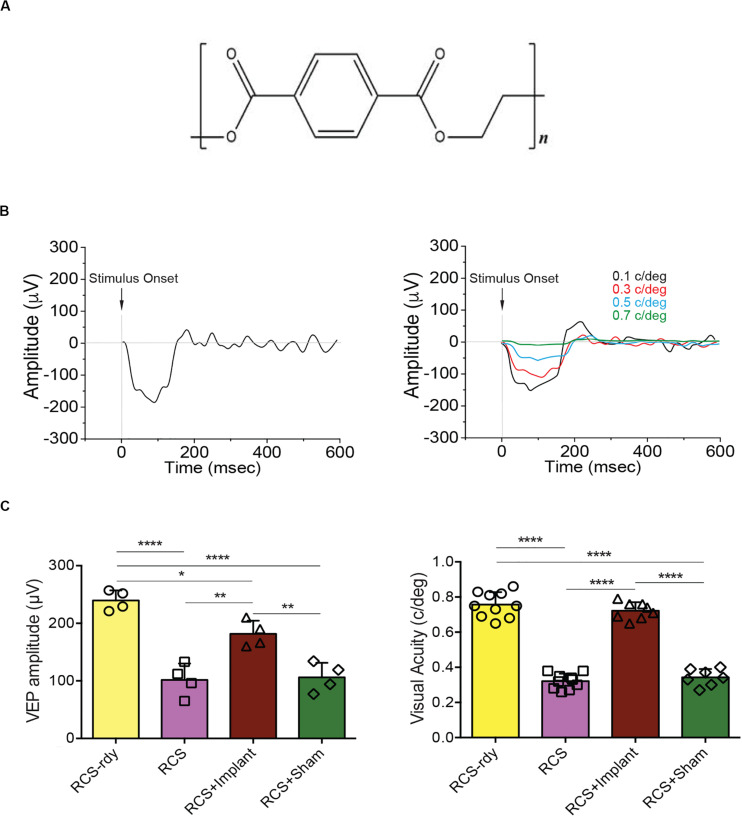
Light sensitivity and visual acuity in adult dystrophic RCS rats implanted with the PET-based polymeric prosthesis. (A) Structural formula of polyethylene terephthalate (PET). (B)
Left: representative trace of the visual evoked potential (VEP) recorded in the binocular area of the primary visual cortex in non-dystrophic RCS-rdy rats. Right: representative VEP traces in non-dystrophic RCS-rdy rats showing the progressive decrease of the signal amplitude that occurs with the increase of the spatial frequency of the visual stimulus. (C)
Left: the VEP response to light in naïve RCS dystrophic rats (102 μV) was lower (p < 0.0001) than that observed in RCS-rdy congenic controls (240 μV). Sensitivity to light increased significantly (182 μV) after 1 month of implant with the active device as compared to either non-implanted dystrophic RCS rats (p = 0.0024) or sham-implanted dystrophic RCS rats (p = 0.0038). Light sensitivity in sham-implanted RCS animals did not differ from that seen in naïve RCS rats (n = 4 per experimental group). Right: visual acuity in naïve dystrophic rats (0.32 c/deg) was lower (p < 0.0001) than that of RCS congenic controls (0.76 c/deg) but following 1 month of implantation with the PET-based prosthetic it significantly enhanced (0.72 c/deg) with respect to either naïve RCS animals (p < 0.0001) or sham-implanted RCS rats (p < 0.0001). Data are means ± SD with superimposed experimental points. *p < 0.05; **p < 0.01; ****p < 0.0001; one-way ANOVA/Tukey’s tests (n = 10 for both RCS-rdy and RCS animals; n = 8 for RCS + Implant; n = 7 for RCS + sham).